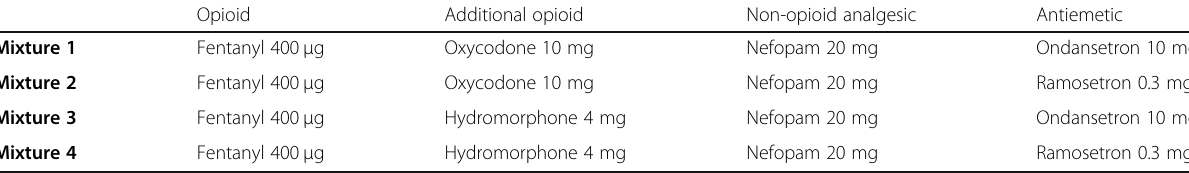
Table 2 Drug combinations evaluated in this study Opioid Additional